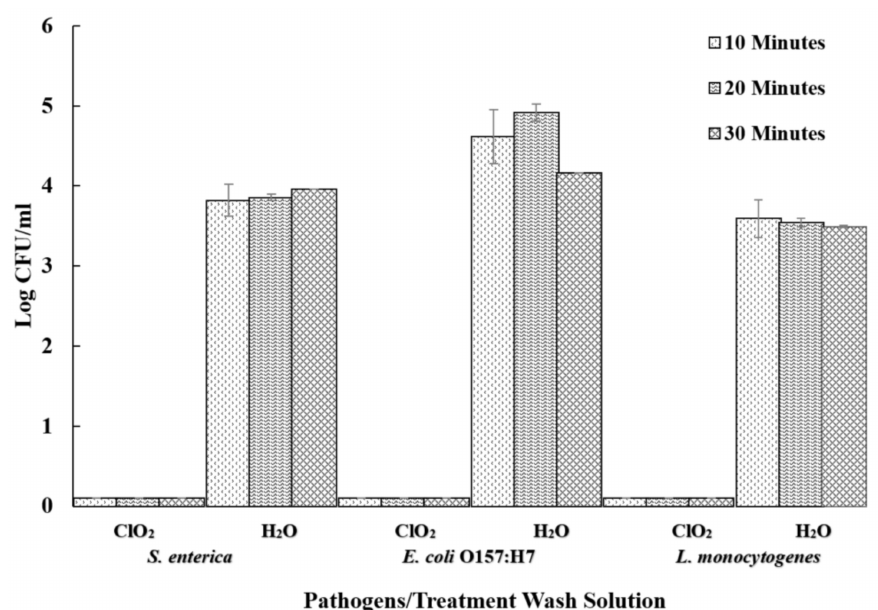
Figure 4. The recovery of pathogens from wash water. Pathogens recovered from wash solution following aqueous ClO 2 treatment (5 ppm) for 10, 20, and 30 min and water treatment at 22 ± 1 ◦ C. Table 1. Cross-contamination of pathogens on noninoculated sweet potatoes washed together with inoculated sweet potatoes with or without aqueous chlorine